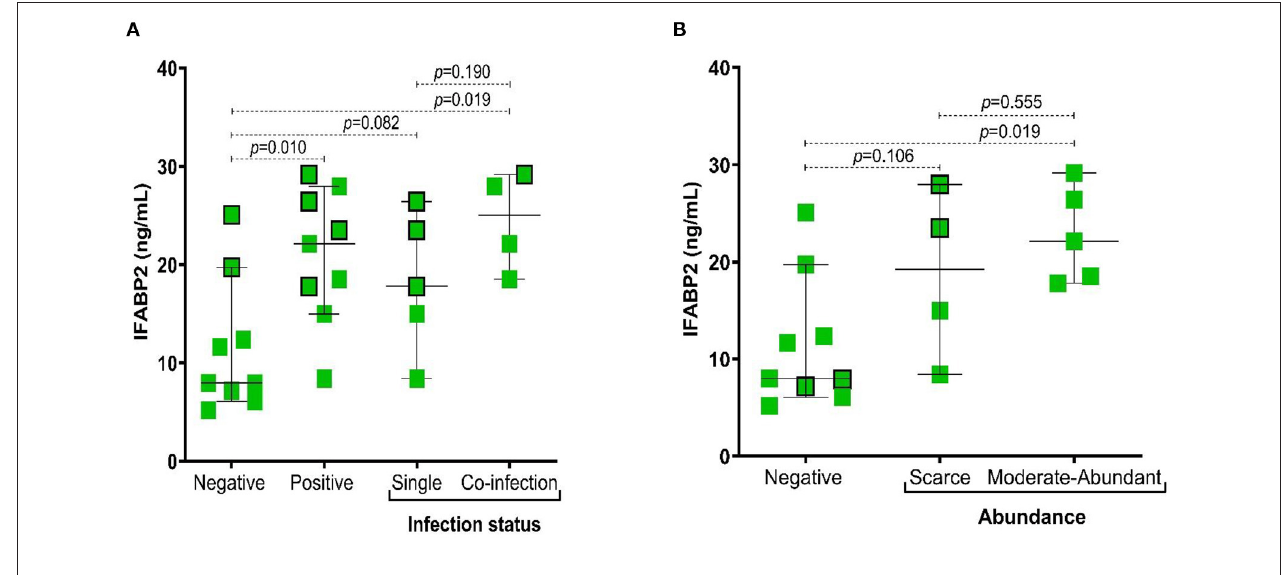
FIGURE 3 | Association of IFABP2 levels according to infection status by intestinal protozoa and abundance of Blastocystis sp . (A) IFABP2 serum levels according to infection status; (B) IFABP2 serum levels according to the abundance of Blastocystis sp. Bars represent the median with the P 5 -P 95 range. The boxes with borders represent patients without pharmacological therapy. Statistical analyses were performed by Mann–Whitney U test. Significance was set at p < 0.05.